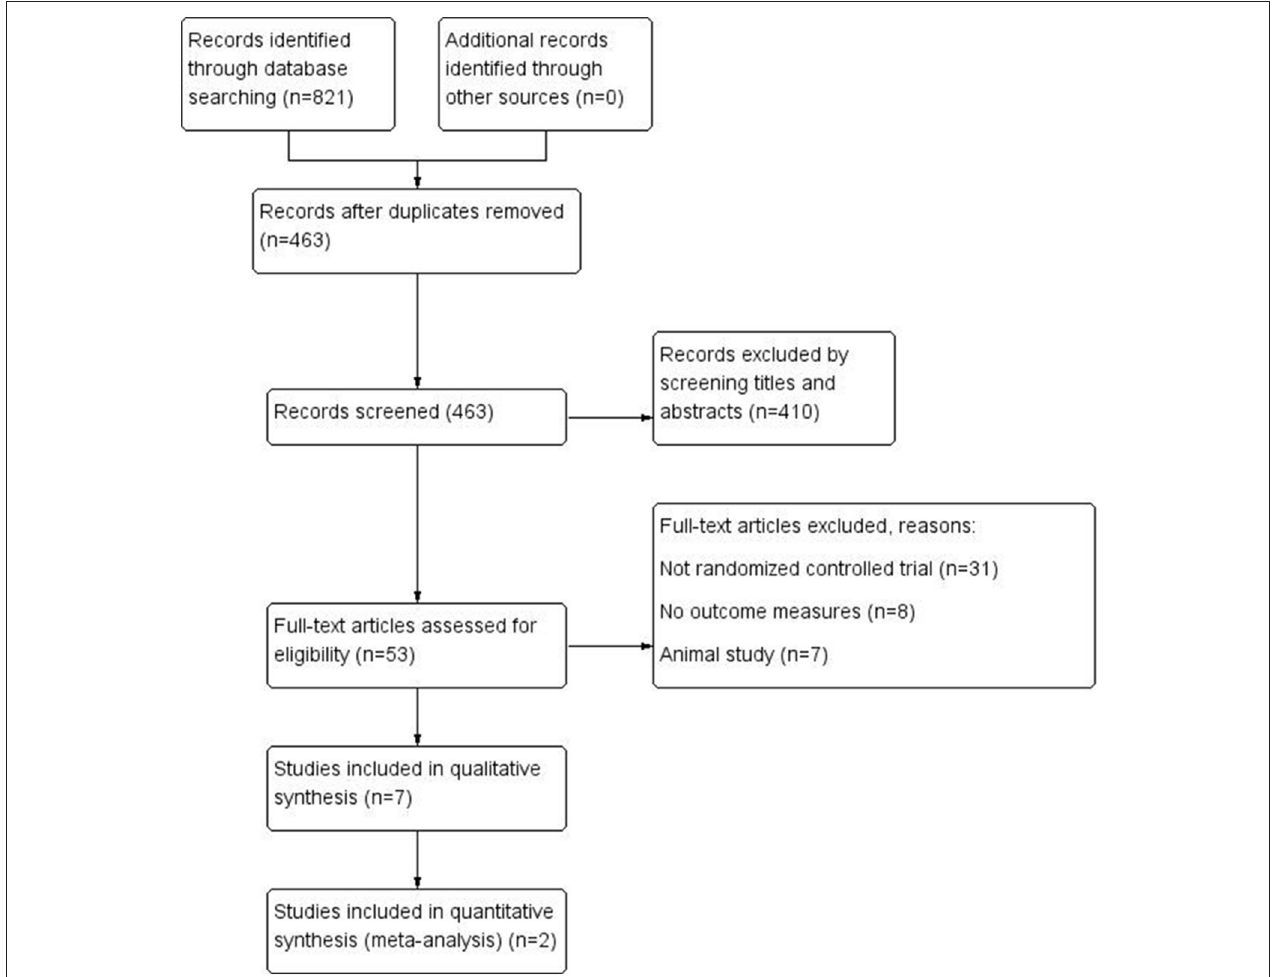
FIGURE 1 | Study flow